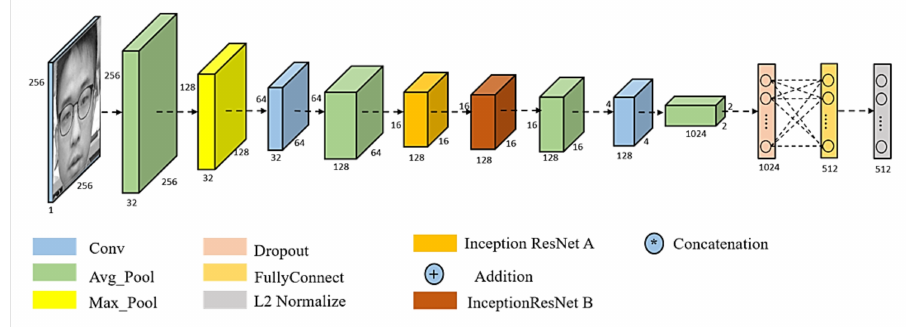
Figure 5. The framework of FN13 model.